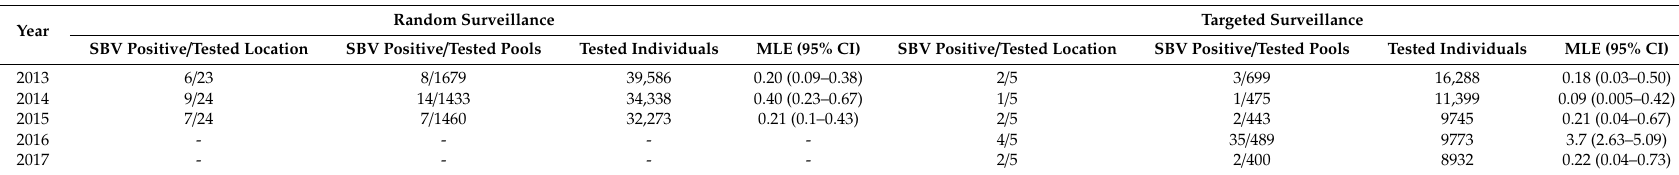
Table 2. The comparison of results of two surveillance approaches: random (23–24 traps randomly distributed over the country [Figure 1]) and targeted (based on five, selected traps). The targeted surveillance between 2013 and 2015 concerns the same five traps as for 2016 and 2017. The results of SBV testing are presented by number of location, number of pools, number of tested individual Culicoides and maximum likelihood estimation of infection rate (MLE) with 95% confidence interval